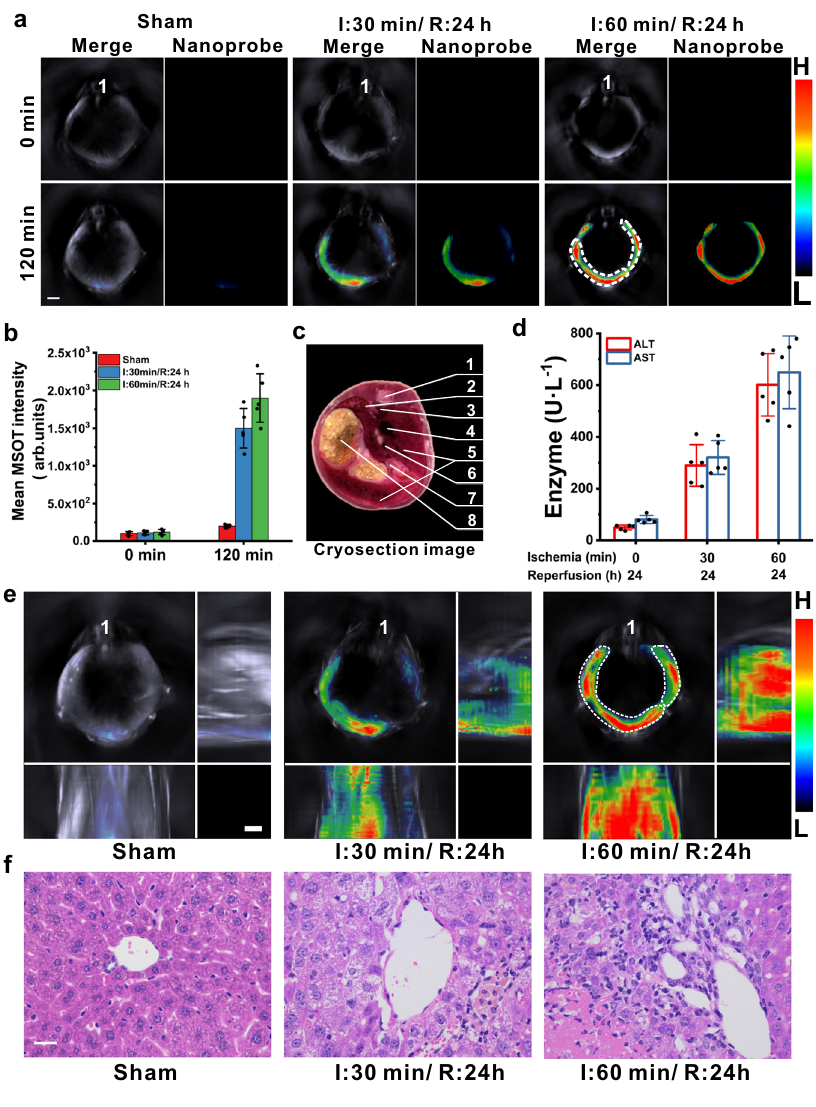
Fig. 7 Application of nanoprobe BTPE-NO 2 @F127 in liver ischemia-reperfusion injury mouse model via MSOT imaging. a Representative cross-sectional MSOT images for different groups at 0 min and 120 min after i.v. injection of the nanoprobe BTPE-NO 2 @F127 (I ischemia, R reperfusion). Organ labeling: “ 1 ” represents spinal cord. White dotted circle: liver region. Scale bar: 3.0 mm. Color bar: L: 6.1 × 10 1 , H: 4.1 × 10 3 (arb. units). b Mean MSOT intensities corresponding to ROI (white dotted line) in a . n = 5 animals per group. c Cryosection image of a male mouse with its cross-section location matching those in a . 1: Spinal cord; 2: Spleen; 3: Thoracic aorta; 4: Vena cava; 5: Liver; 6: Portal vein; 7: Intestines; 8: Stomach. The cryosection image is from CryoMOUSE TM atlas provided with the MSOT equipment for anatomical reference. d Serum levels of two enzymes ALT and AST from various groups. n = 5 animals per group. e Typical 3D MSOT images for different groups at 120 min post-injection of BTPE-NO “ 1 ” represents spinal 2 @F127 nanoprobe. cord. White dotted circle: liver region. Color bar: L: 6.1 × 10 1 , H: 4.1 × 10 3 (arb. units). f Representative H&E staining of liver sections from different mouse groups ( n = 5 animals per group. The experiments were repeated independently three times with similar results. Scale bar: 20 μ m). Data with error bars are all presented as mean ± SD. I ischemia, R reperfusion, MSOT multispectral optoacoustic